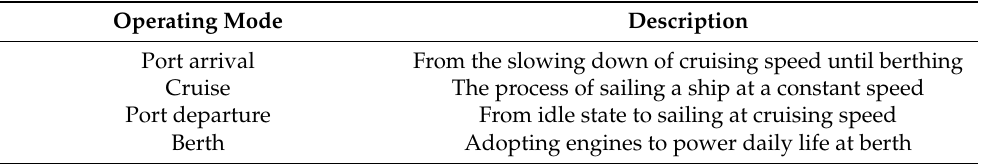
Table 4. Test operating mode of